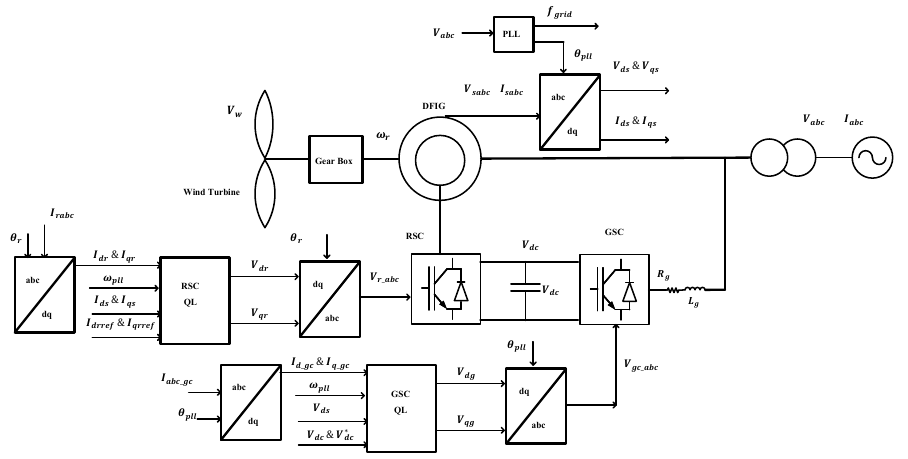
Figure 13 . Block diagram with QL